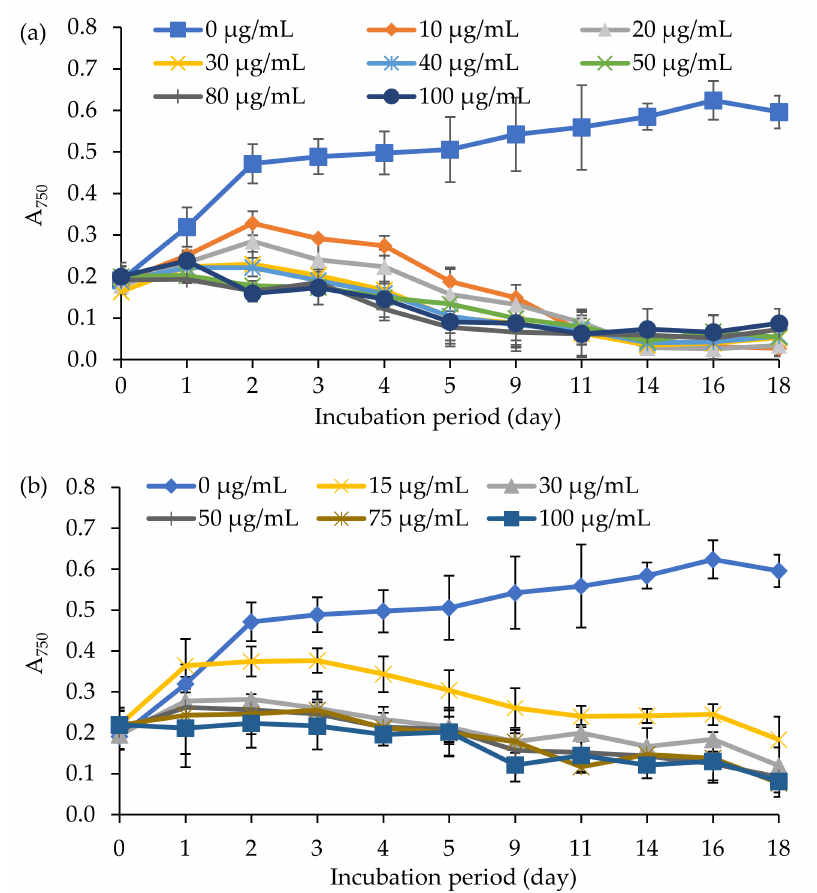
Figure 1. Growth inhibitory effects of the antibiotics ( a ) hygromycin (0, 10, 30, 40, 50, 80, and 100 µ g mL − 1 ) and ( b ) zeocin (0, 15, 30, 50, 75, and 100 µ g mL − 1 ) on E. gracilis . The growth of E. gracilis was assayed by measuring culture absorbance at 750 nm. Each value indicates the mean ± standard deviations of three